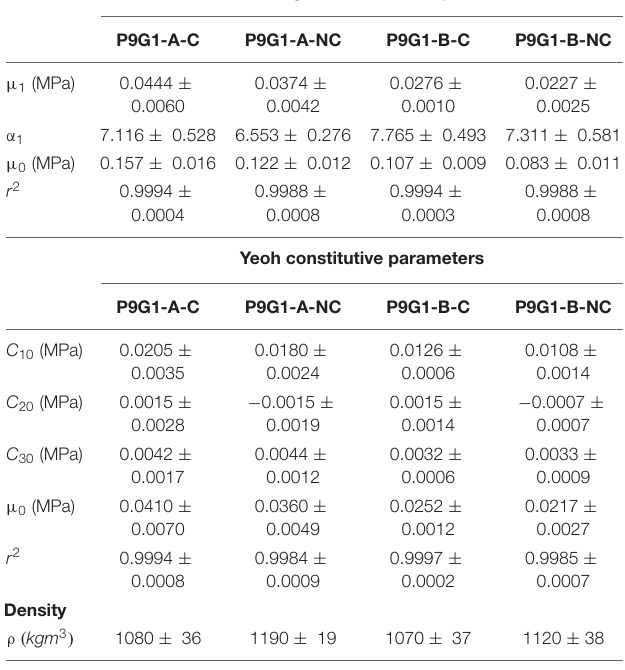
TABLE 3 | First order Ogden and Yeoh constitutive parameters fitted to PVA/gelatin compression data and densities of all PVA/gelatin cryogel compositions (mean ±